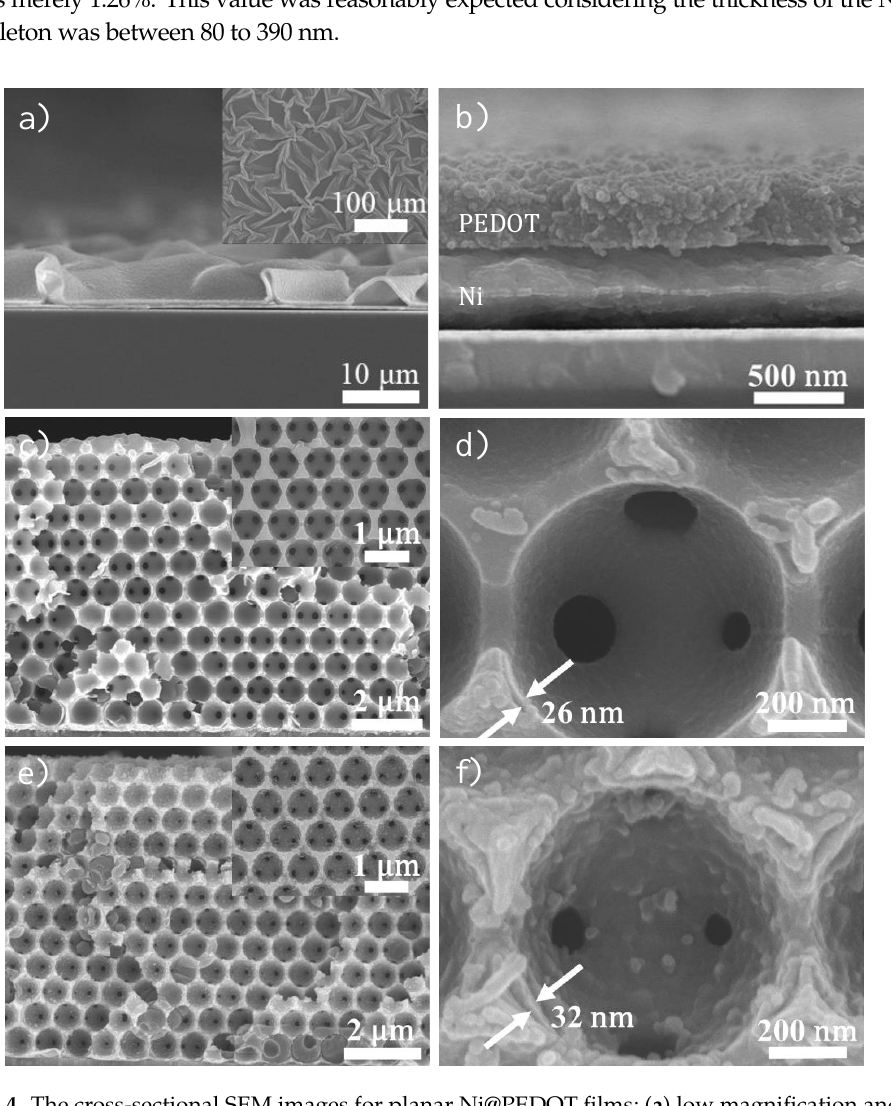
Figure 4. The cross-sectional SEM images for planar Ni@PEDOT films; ( a ) low magnification and ( b ) high magnification, Ni@PEDOT inverse opals; ( c ) low magnification and ( d ) high magnification, and Ni@PEDOT / Au inverse opals; ( e ) low magnification and ( f ) high magnification. The insets are their corresponding top-view